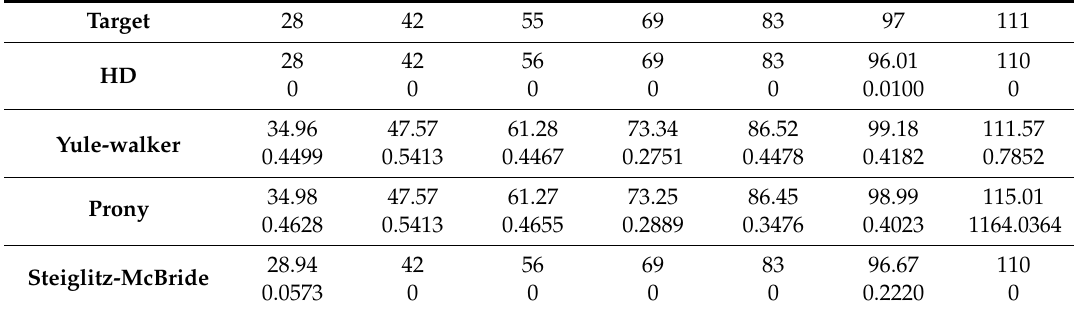
Table 2. Experiment results as mean (upper row) and variance (lower row) for 20 ensemble length.